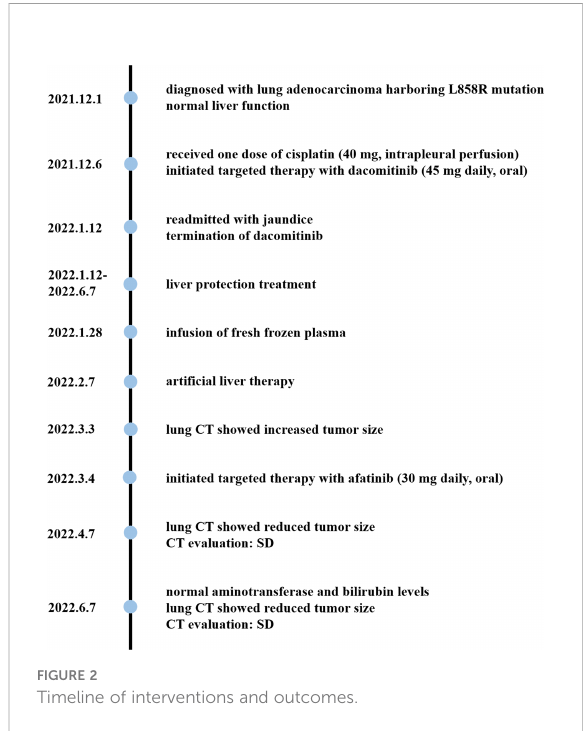
FIGURE 2 Timeline of interventions and